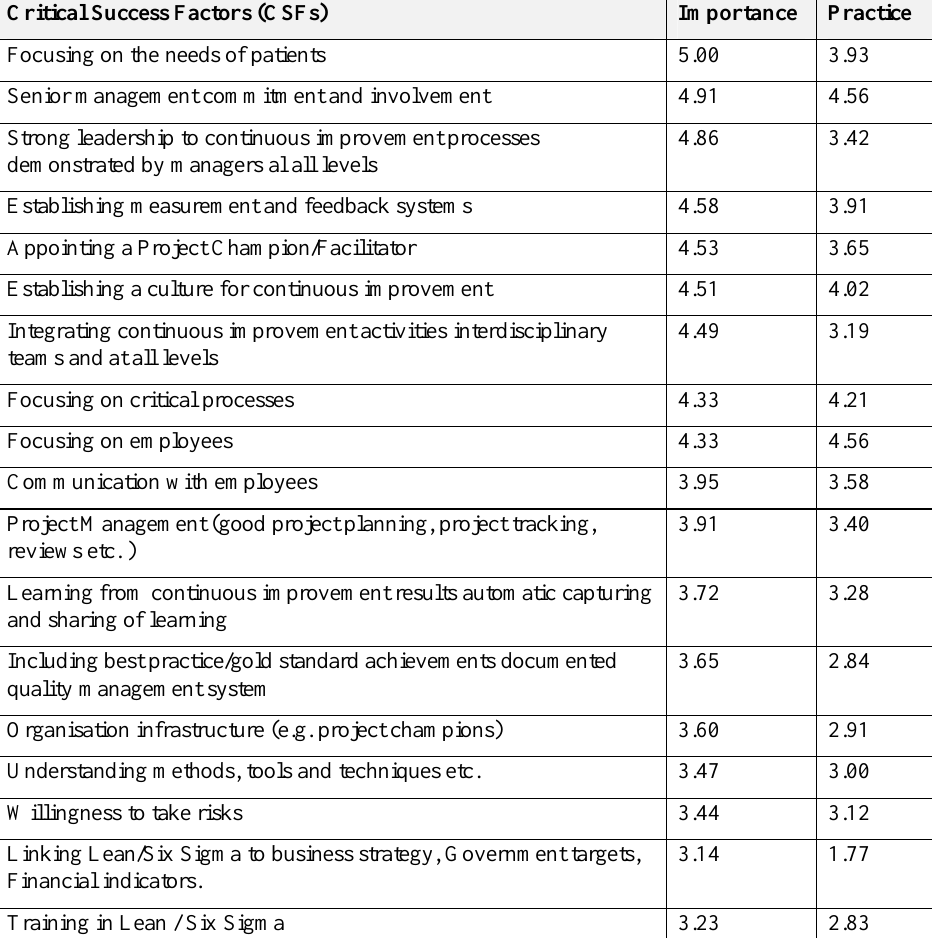
Table 3 – CSFs for Successful introduction of Lean and Six Sigma Critical Success Factors